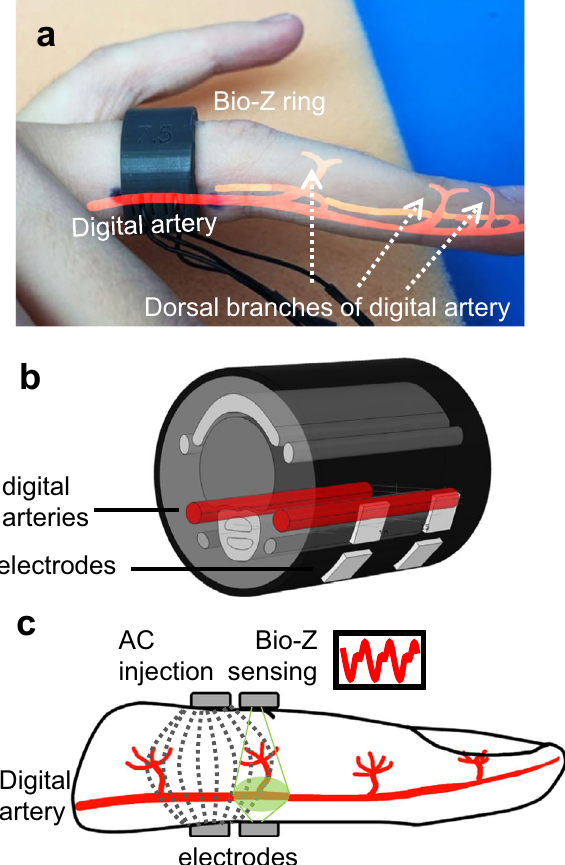
Fig. 1 Bioimpedance (Bio-Z) ring sensor for arterial blood fl ow and pressure sensing. a A fabricated ring example custom fi t to user ’ s fi nger size. b The fi nite element model of the human fi nger used in guiding ring design. c Cross-section of the four electrode bioimpedance sensing, with dashed lines representing high frequency alternating current (AC) distribution within the fi nger, and green area shows sensitive area for Bio-Z sensing